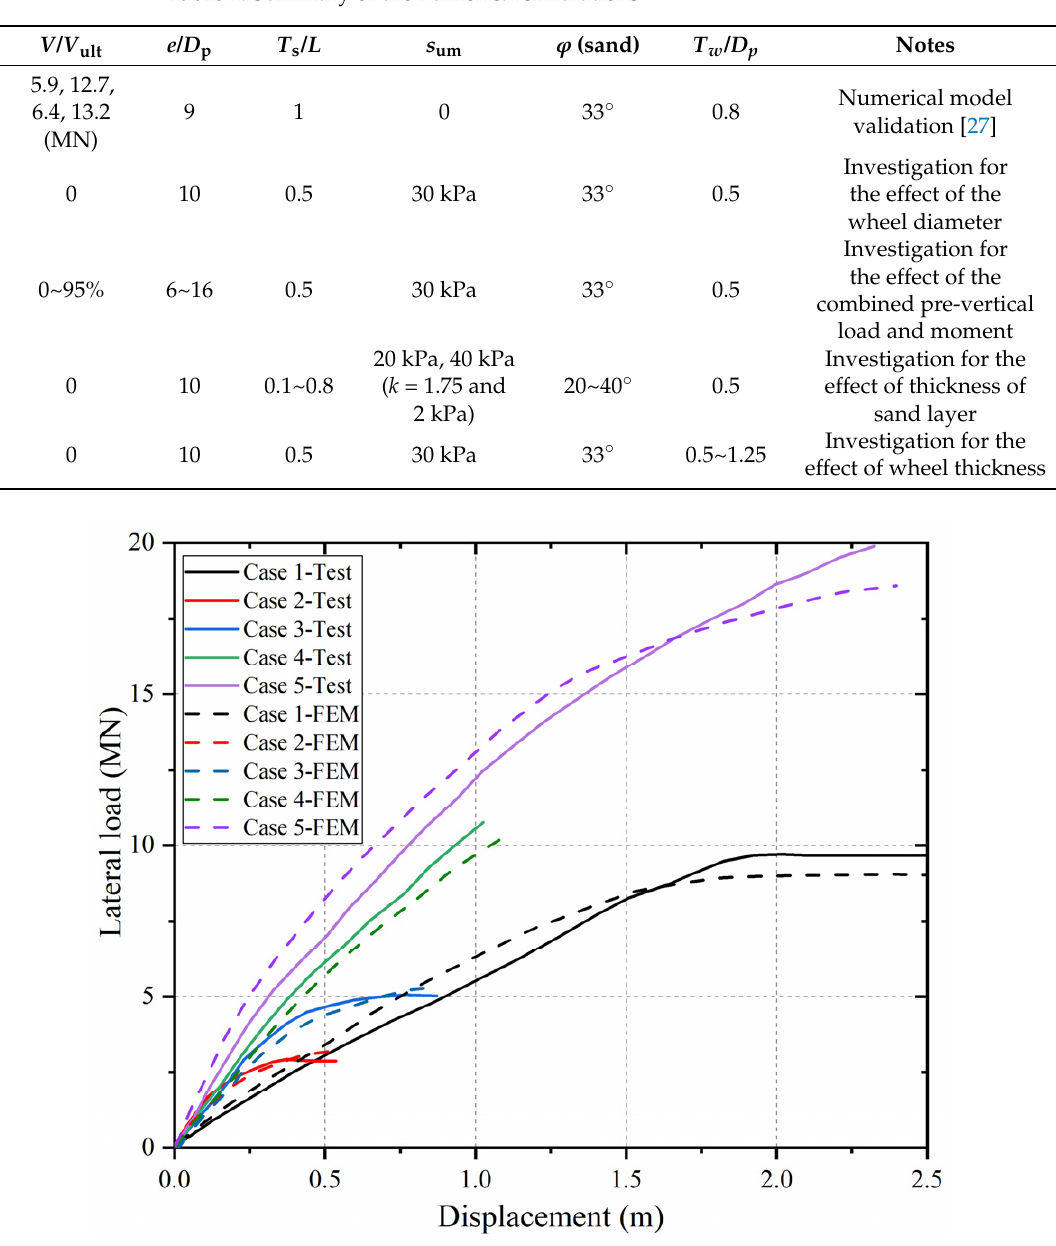
Figure 3. Lateral load-deflection curves obtained from FEM and centrifuge tests. Table 1. Summary of the numerical simulations.